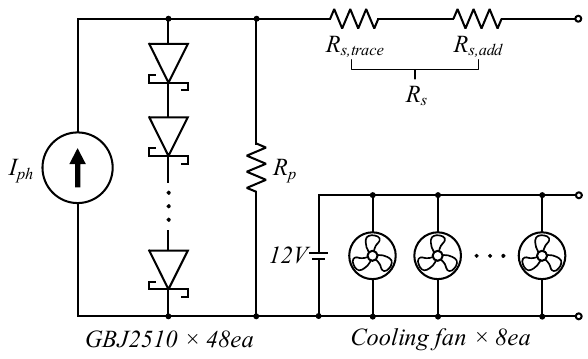
Figure 11. Hardware configuration of the 400 W PVE.